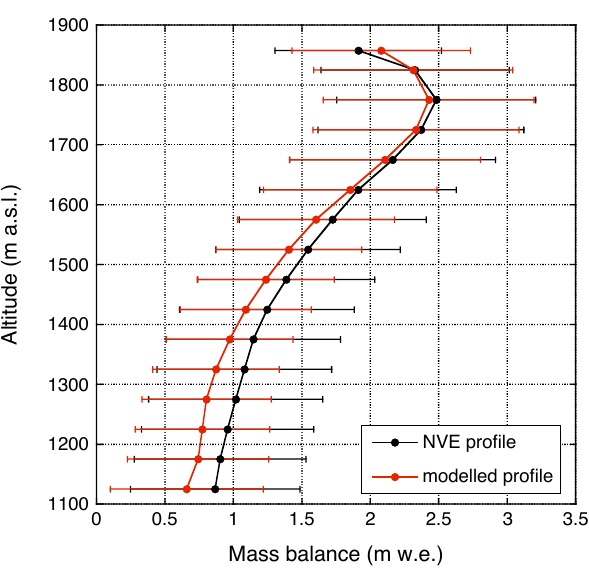
Fig. 3. Altitudinal profiles of the mean measured and modelled winter mass balance for Rembesdalsskåka for 33 years in the pe- riod 1963–2005. The modelled profile is calculated with local me- teorological data (Sect. 4.1). The error bars represent one standard deviation, computed from the 33 annual